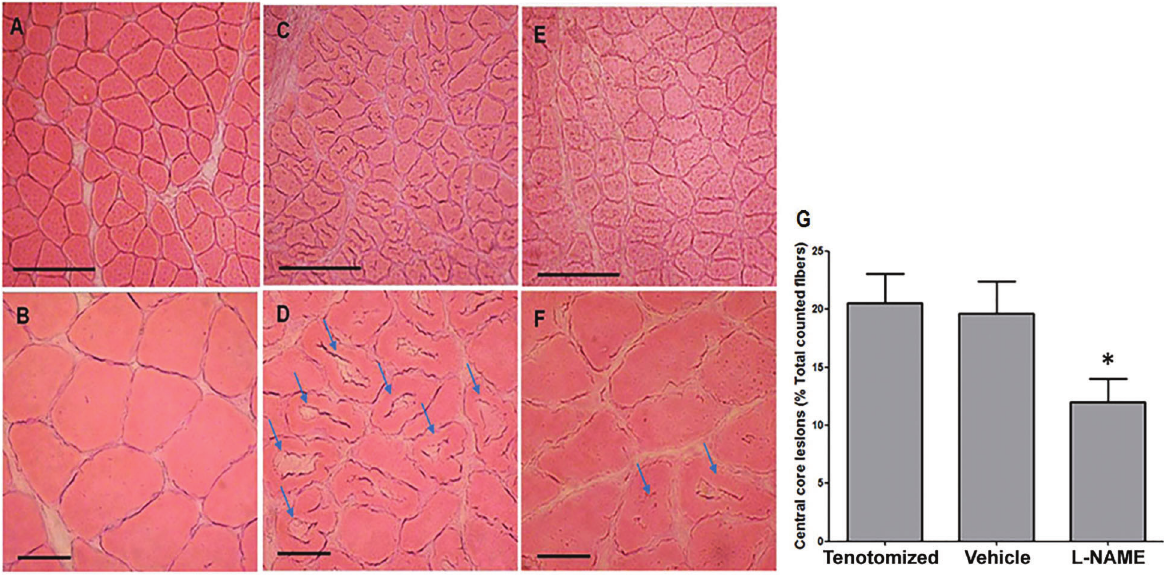
Figure 4. Analysis of central core lesion (CCL) occurrence on day 14 after injury. Control group ( A , B ), tenotomized group ( C , D ) and L-NAME group ( E, F ). Muscle fi bers from the L-NAME group displayed remarkable histological alterations characteristic of CCL. Although CCLs were present in the L-NAME group, the occurrence of lesions was smaller than in the control group. Arrows: CCL in muscle fi ber. Scale bar: 200 m m ( A , C , E ). Scale bar: 50 m m ( B , D , F ). n X 4 rats/group. G , Quanti fi cation of muscle fi bers with CCL. A total of 180 fi bers were evaluated from rats that underwent tenotomy (tenotomized, vehicle and L-NAME groups). Tenotomized and vehicle groups showed about 20% of muscle fi bers with CCL. Treatment with L-NAME displayed a signi fi cant reduction of fi bers with CCL (about 12%). Data are reported as means ± SD. *P o 0.05 vs tenotomized and vehicle